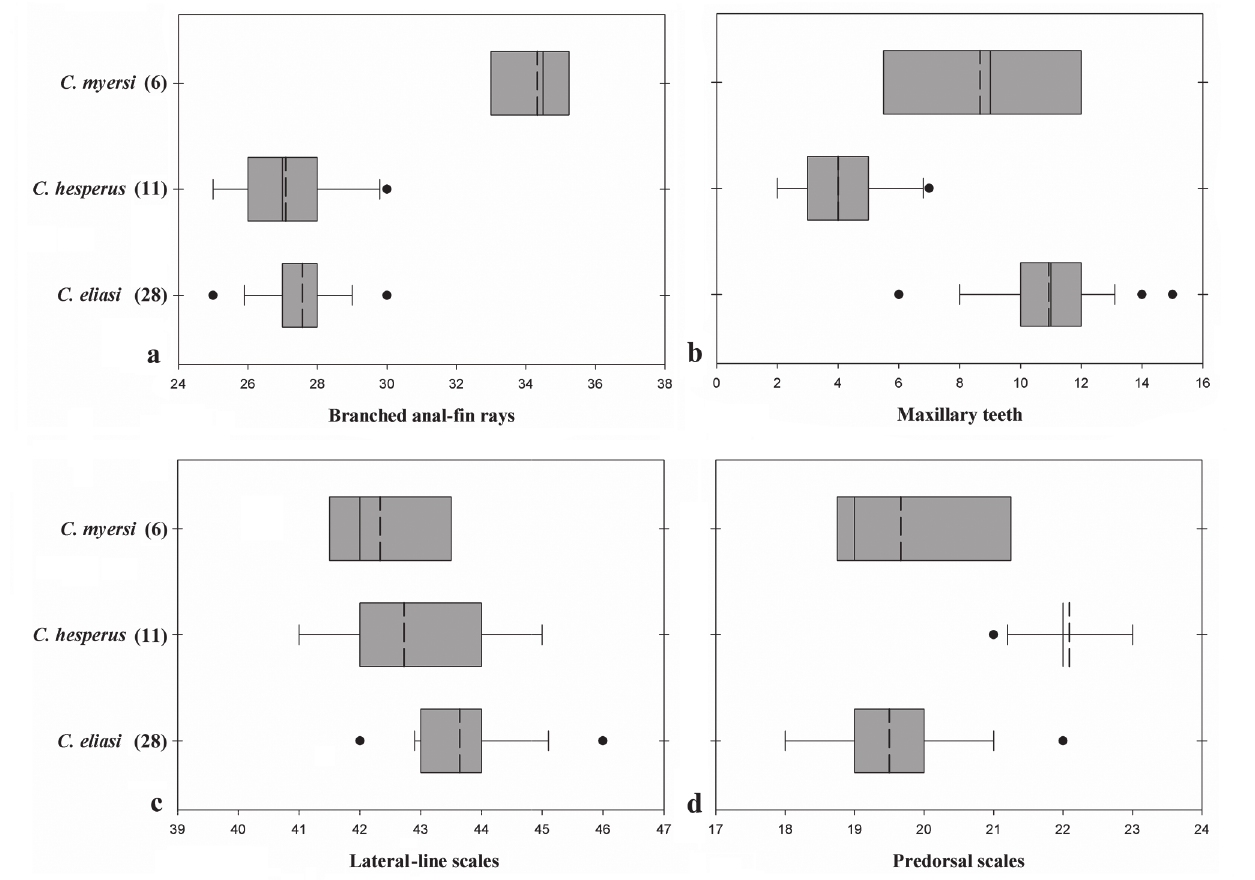
Fig. 5. Comparative Tukey box plots showing the variation of ( a ) number of branched rays of anal fin, ( b ) number of teeth in maxilla, ( c ) number of lateral-line scales, and ( d ) predorsal scales of Chrysobrycon eliasi , C. hesperus , and C. myersi . Number of specimens between